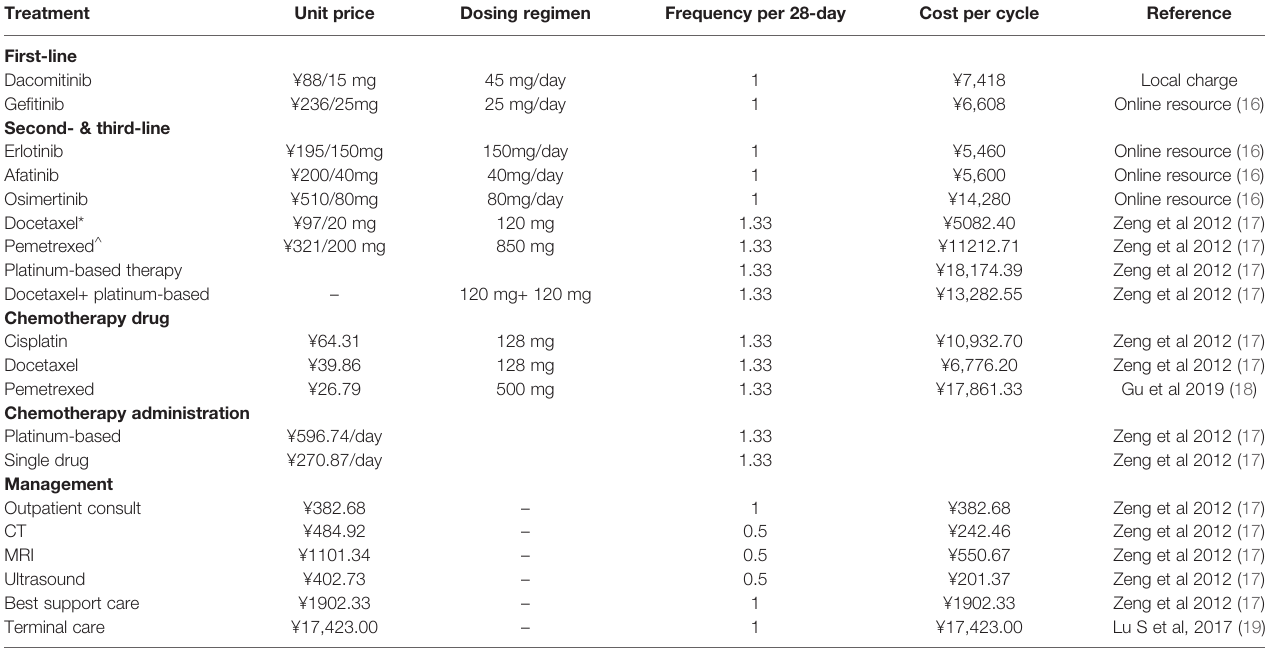
TABLE 1 | Unit cost of healthcare resources included in the